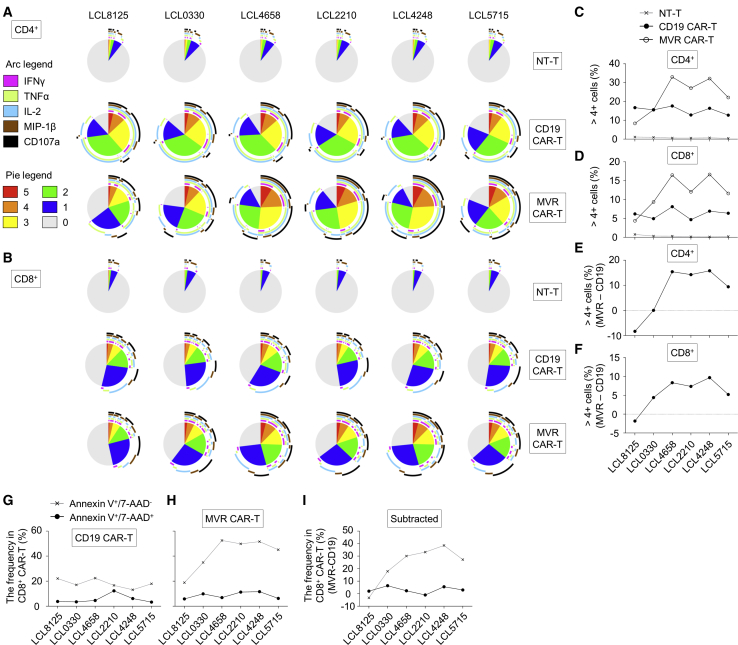
MVR CAR-T System Defines Polyfunctional Plateau of CAR-T in a High Affinity RangeThe effect of affinities on CAR-T polyfunctionality was evaluated using MVR CAR-T system. (A and B) The polyfunctionality of CD19 CAR-Ts or MVR CAR-Ts stimulated with a panel of LCLs (which is shown in Figure 5A). Non-transduced T cells (NT-Ts) served as negative controls. The length of the arc of each color indicates the frequency of cells expressing the corresponding marker. The area of the pie of each color indicates the frequency of cells expressing the given number of functional markers. CD4+ (A) and CD8+ (B) cells were analyzed separately. (C and D) The frequency of NT-Ts, CD19 CAR-Ts, and MVR CAR-Ts expressing more than four functional markers. This frequency was determined based on the numeric data of polyfunctional analysis. CD4+ (C) and CD8+ (D) cells were analyzed separately. (E and F) The relationship between the affinity and polyfunctionality of MVR CAR-T. The frequency of CD19 CAR-Ts expressing more than four functional markers was subtracted from that of MVR CAR-Ts. The numerical data of (C) and (D) were used for the calculation. CD4+ (E) and CD8+ (F) cells were calculated separately. (G and H) The activation-induced cell death of CD19 CAR-Ts (G) or MVR CAR-Ts (H) stimulated with LCLs. The increase in the frequency of Annexin V+/7-AAD− apoptotic cells and Annexin V+/7-AAD+ dead cells was calculated. (I) The apoptotic/dead-cell frequency of CD19 CAR-Ts was subtracted from that of MVR CAR-Ts to eliminate inter-LCL variation. The numerical data of (G) and (H) were used for the calculation.